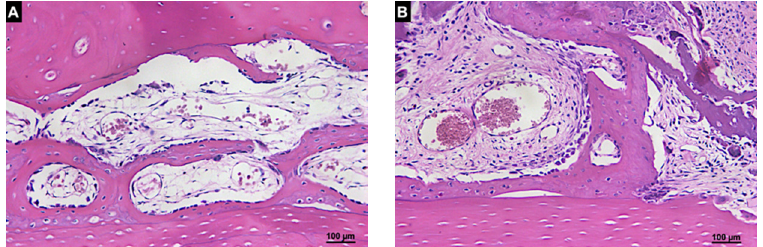
Figure 8. Histologic photomicrography of the Base region in the autogenous ( A ) and xenogenous ( B ) graft after 20 days of healing. New bone was found forming bridges between the grafts and the cortical bone of the recipient site in both groups. Hematoxylin and eosin stain; magnification 200×.